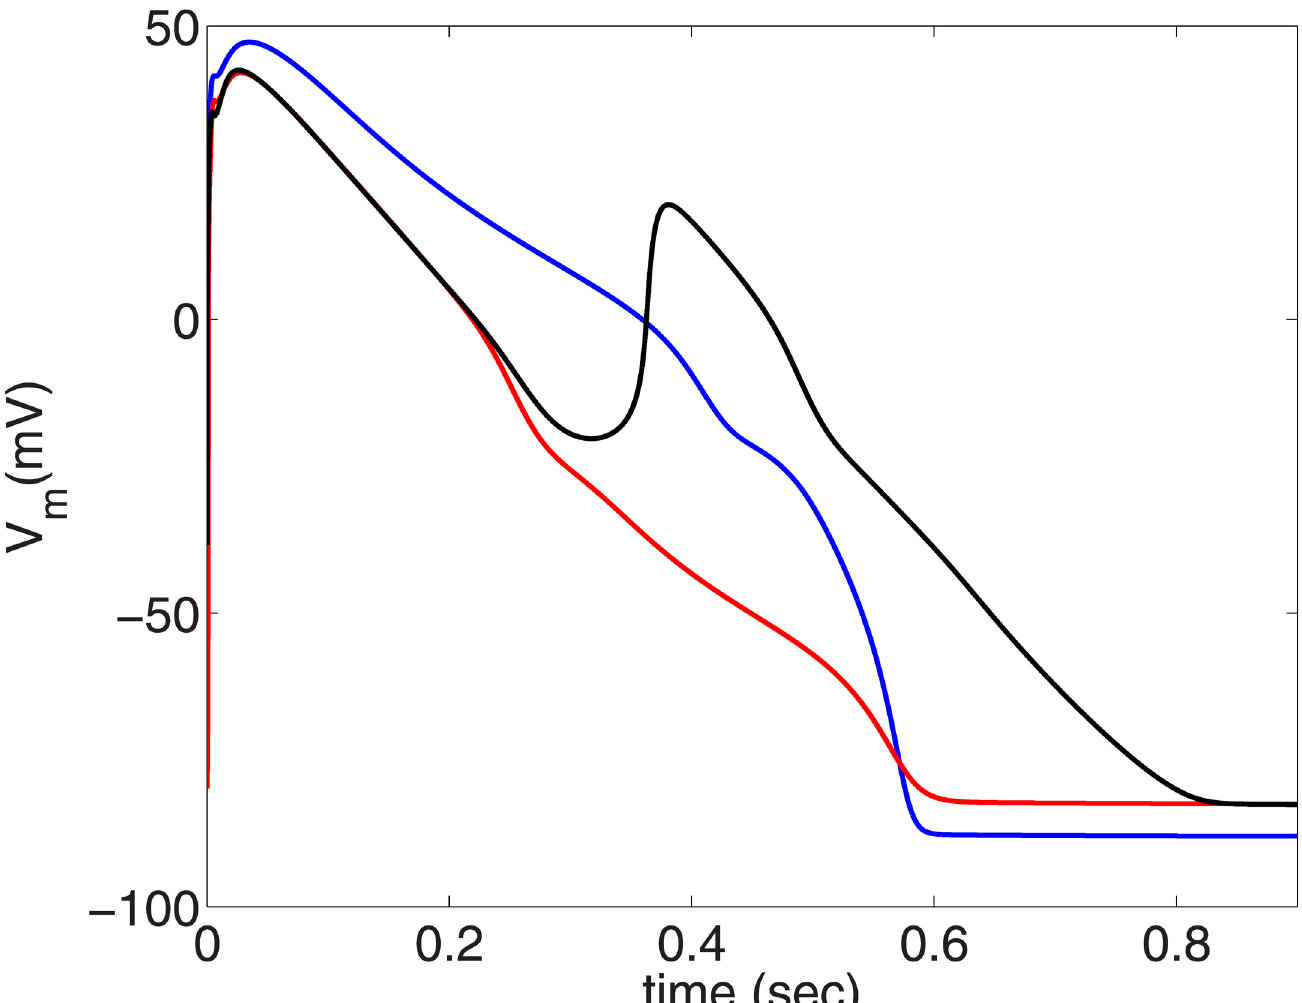
Fig 13. Action-potential plots showing the enhancement in the EAD depending on the EAD myocyte-fibroblast pattern (Fig 12). Plots of V m versus time showing the three action potentials recorded from the middle myocyte of the EAD segment (cell number 140) for three different configurations of the cable: the blue AP is for the case where the EAD segment has no fibroblasts attached to it (Fig 12(A)); the red AP arises when the EAD segment is homogeneously coupled to fibroblasts (Fig 12(B)); and the black AP is obtained when the fibroblasts are attached to the middle of the EAD segment (Fig 12